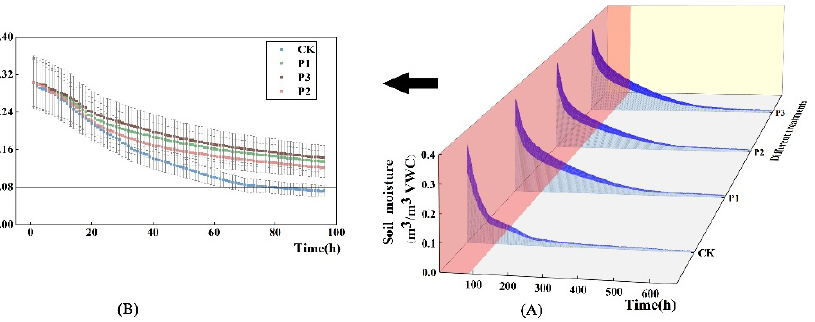
Figure 5. Soil moisture content with various soil bacteria. ( A ) Soil moisture content from 0 to 28 days; ( B ) Soil moisture content from 0 to 4 days .